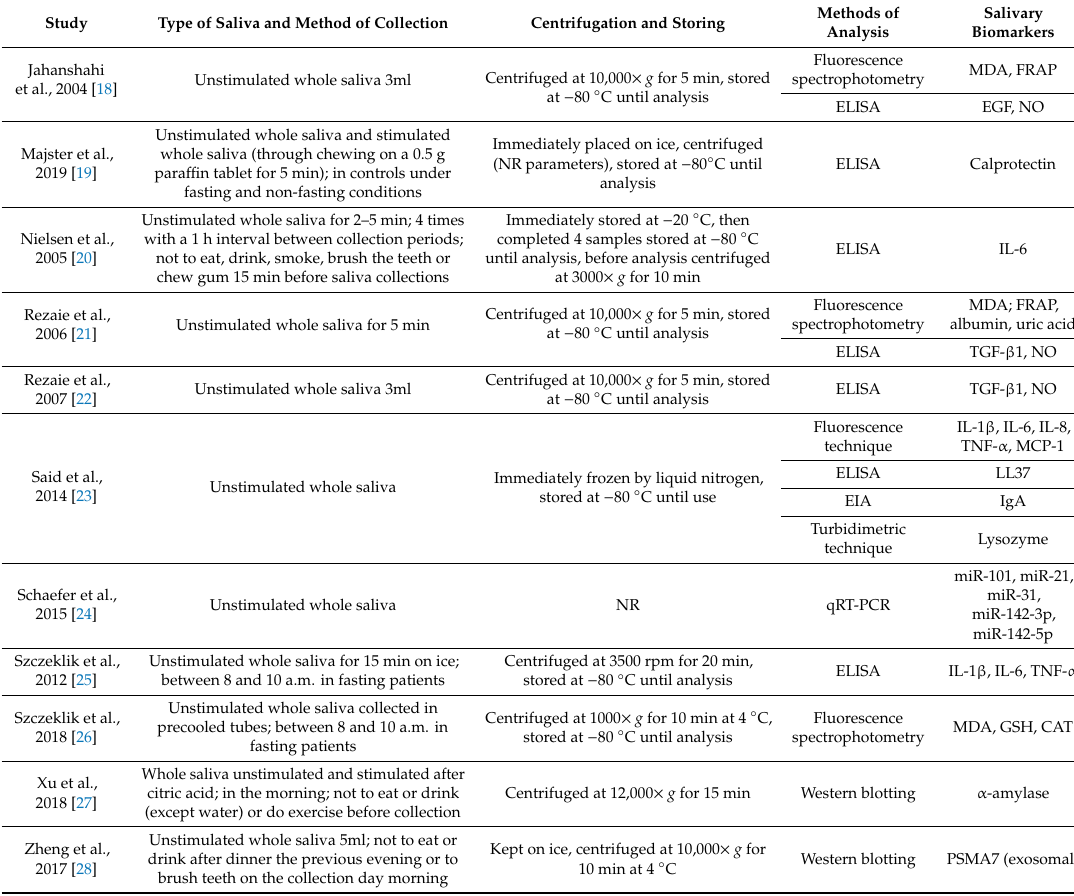
Table 2. Methods of collection and analysis of